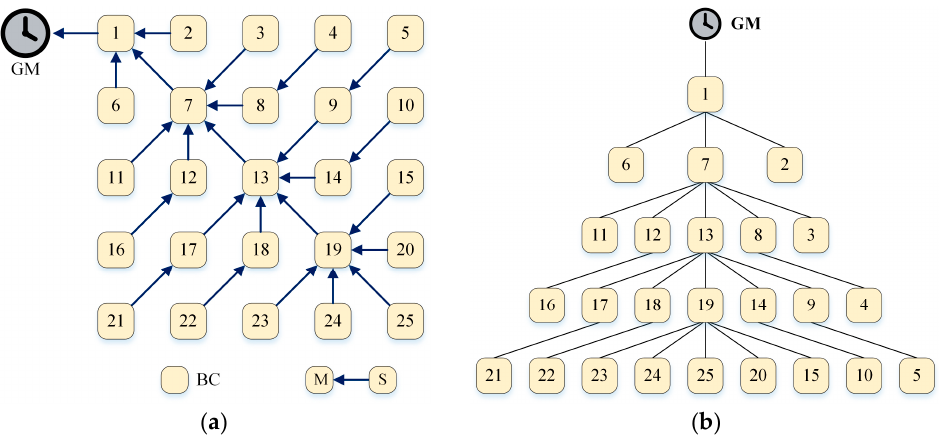
Figure 4. The master-slave hierarchy established by the BMC algorithm. ( a ) Master-slave hierarchy; and ( b ) synchronization tree.